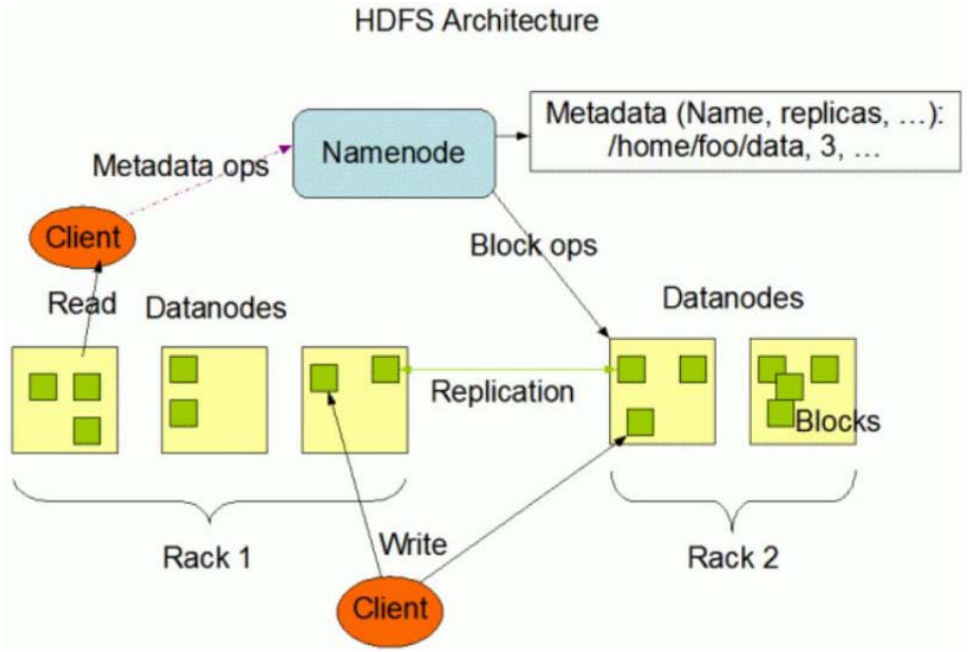
Figure 5. Hadoop Distributed File System